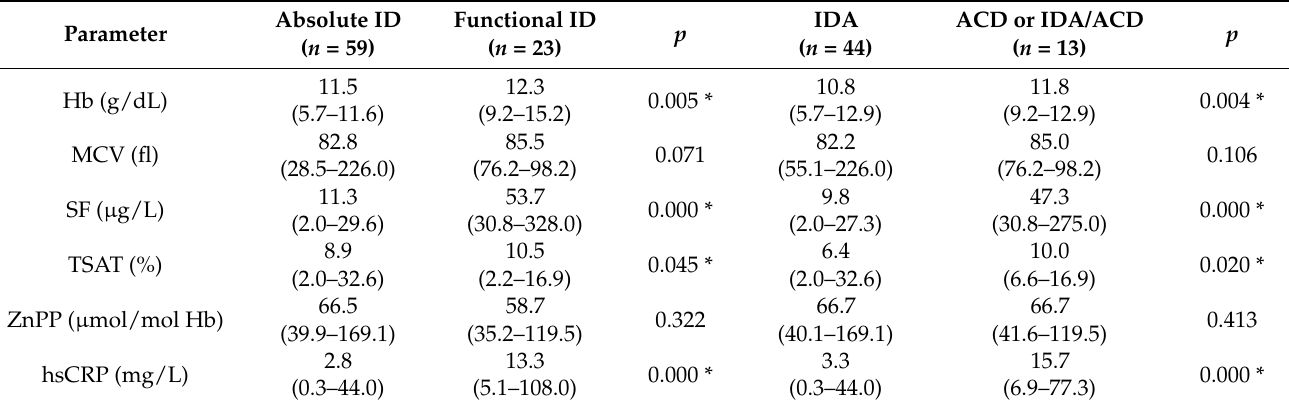
Table 2. Laboratory markers according to iron